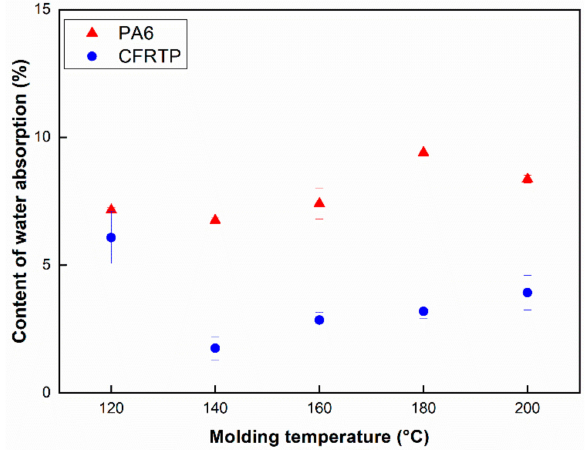
Figure 4. Water absorption content of the pure PA6 and CFRTP